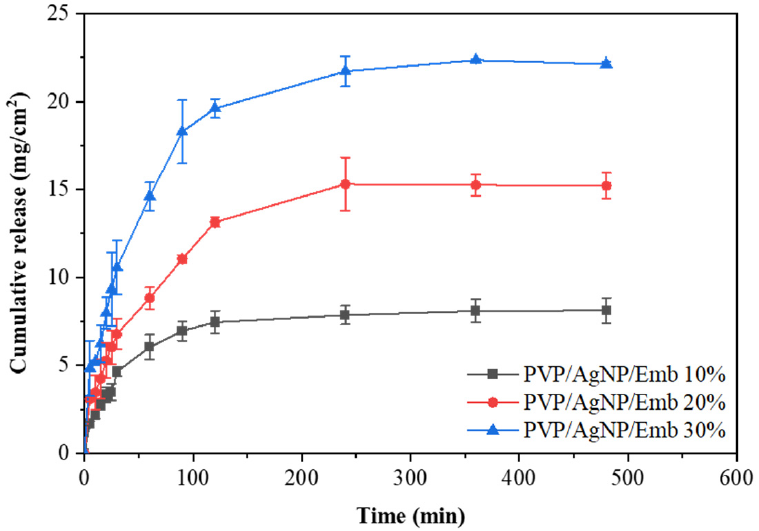
Figure 8. Cumulative release of Phyllanthus emblica extract from spray-on dressing films loaded with different amounts of extract.